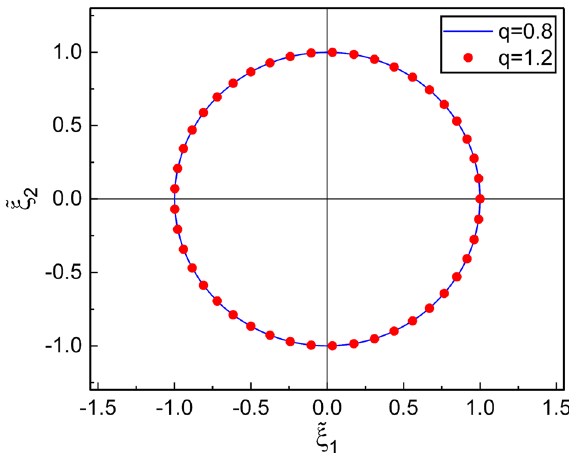
1 , γ 1 , (cid:31) 1 , 0.1 , m = = = = ξ 0 , ϕ( 0 ) ) (1, ˜ =